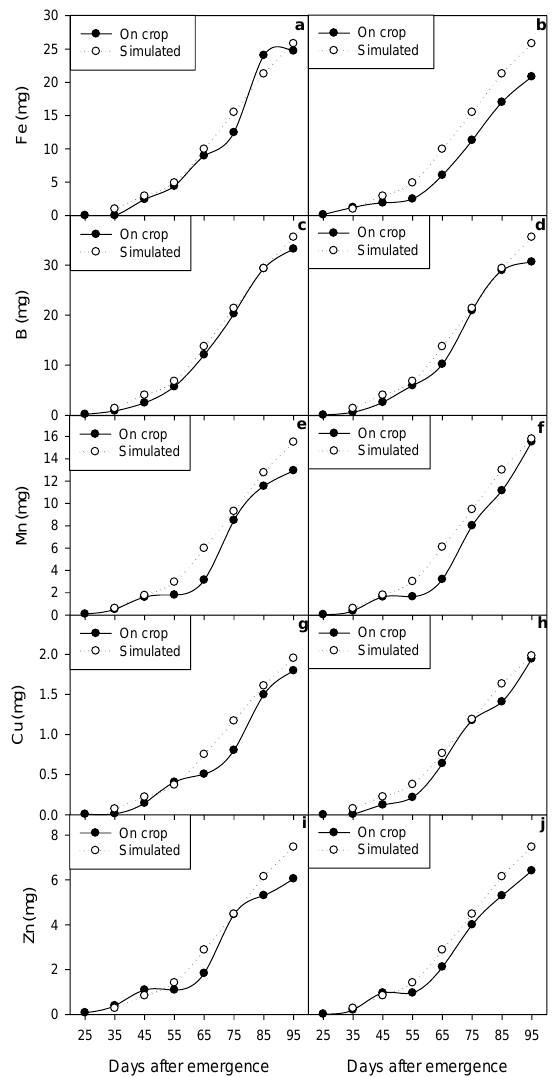
Figure 6. Comparison between the real and dynamically simulated data for micronutrient accumulation in the Vitaly ( a , c , e , g , i ) and Luxell ( b , d , f , h , j ) cucumber plant varieties. The data corresponding to the cultivation cycle used for the validation are presented. The real data are the average of four replicates. Table 3. Values of the indices used to evaluate the simulation efficiency of the dynamic model during the calibration and validation process using the data obtained from the 2015 to 2016 crop cycles, respectively.